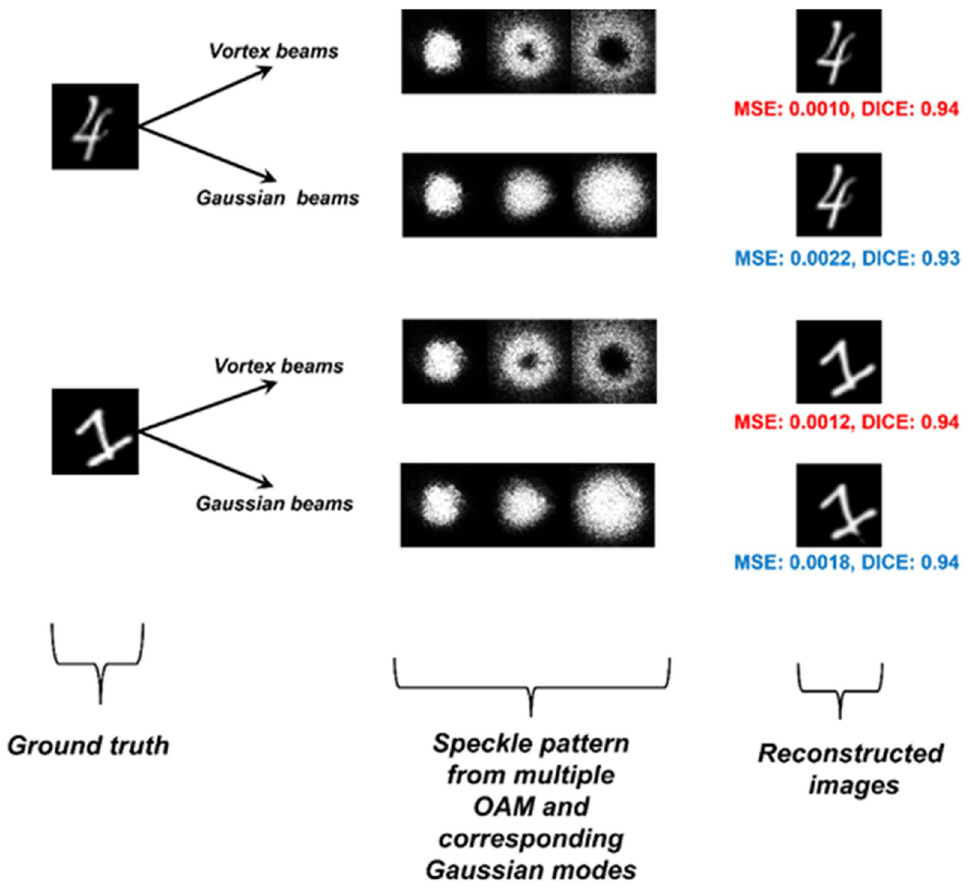
Figure 5. The patterns from the vortex beams and the Gaussian beams and the reconstructed images using the CNN are